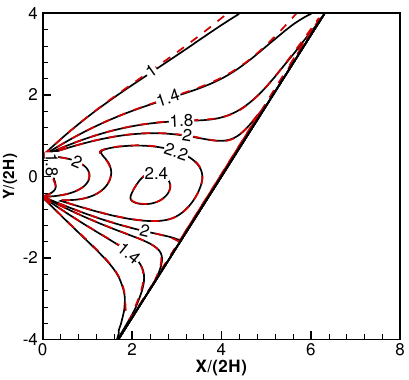
Figure 5. Temperature contours for free jet impingement on an inclined, planar, flat, diffuse reflective plate. Solid: analytical; dashed: DSMC (Direct Simulation Monte Carlo).